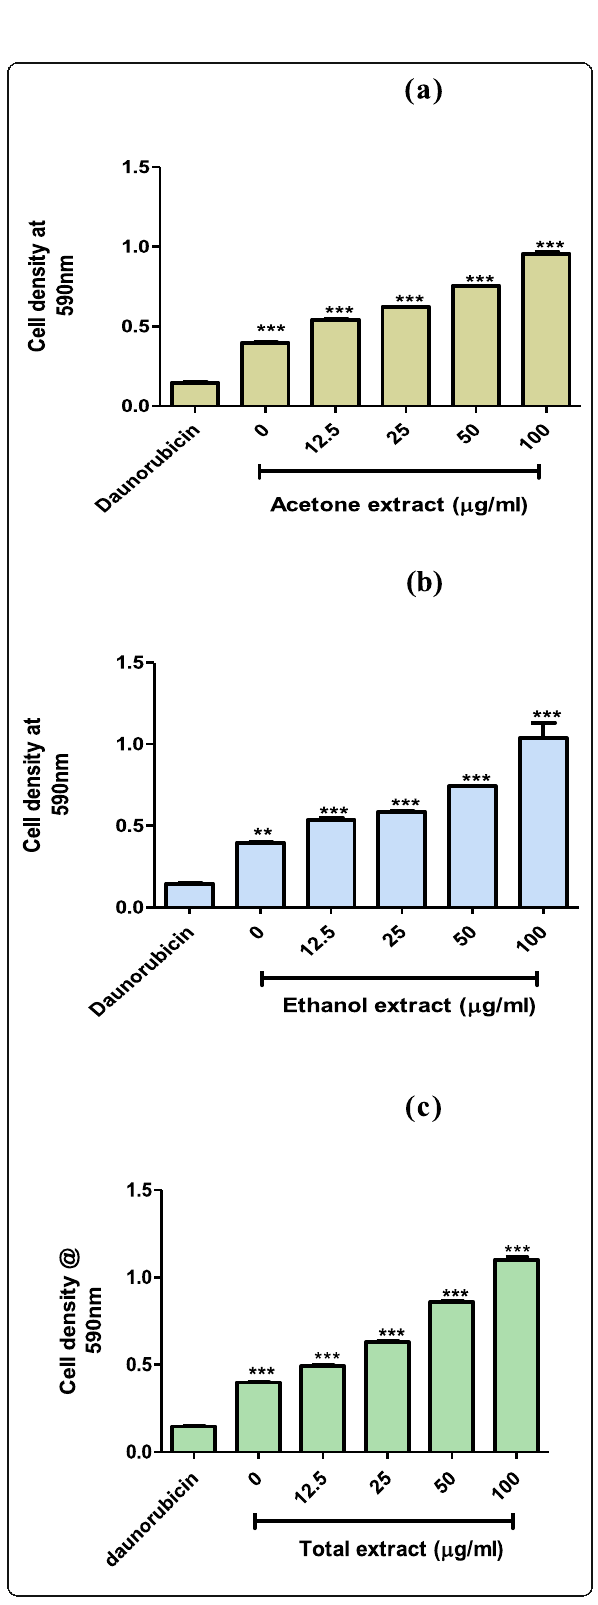
Fig. 6 The effects of the a acetone, b ethanol and c DCM/methanol leaf extracts of T. welwitschii on mouse peritoneal cells. Cells with daunorubicin a standard antibiotic were used as the control. Values are for mean ± standard deviation (error bar) for n = 3. The asterisks indicate a significant difference from the control with ** p < 0.01 and *** p <